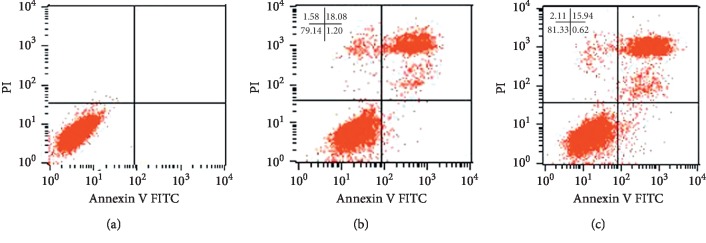
Characterization of apoptosis and the cell cycle. The drug-resistant cell strains were cultured in RPMI-160 medium (containing 5-FU and L-OHP) and plated in 24-well culture plates according to the above descriptions and incubated with a nontoxic dose of compound radix Sophorae injection for 48 h. Flow cytometry detection showed that the number of 5-FU/SW480 and L-OHP/SW480 drug-resistant cells in the G1 phase was decreased compared with that of the control group, and the numbers of cells in the S phase and G2 phase were significantly increased (P < 0.05; Table 1). Apoptosis increased slightly, though the difference was not significant (P > 0.05; Figure 2). (a) None, (b) 5-FU/SW480, and (c) L-OHP/SW480.